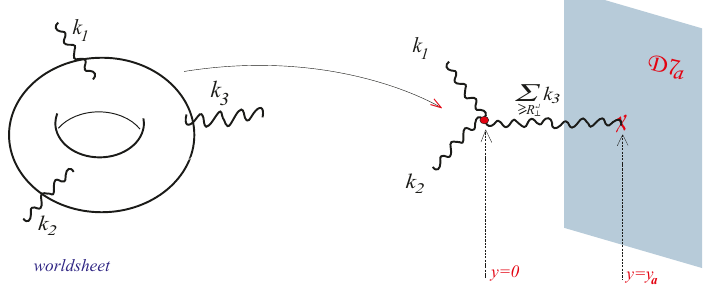
Figure 3 . Degeneration limit genus-3/2 amplitude with two massless gravitons and a KK excitation transmitted towards a D 7